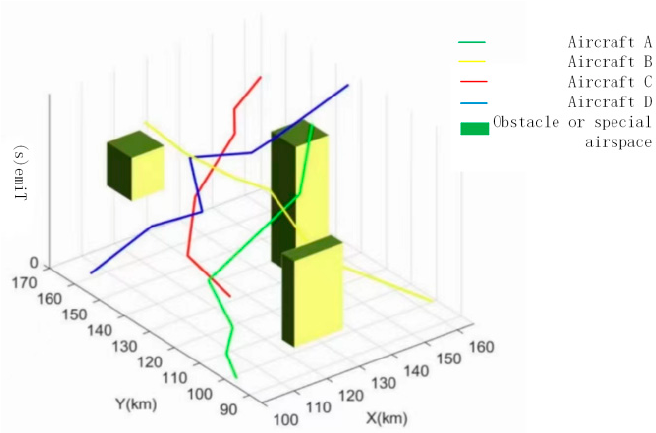
Figure 12. A schematic diagram of 2D track planning results for four aircrafts.